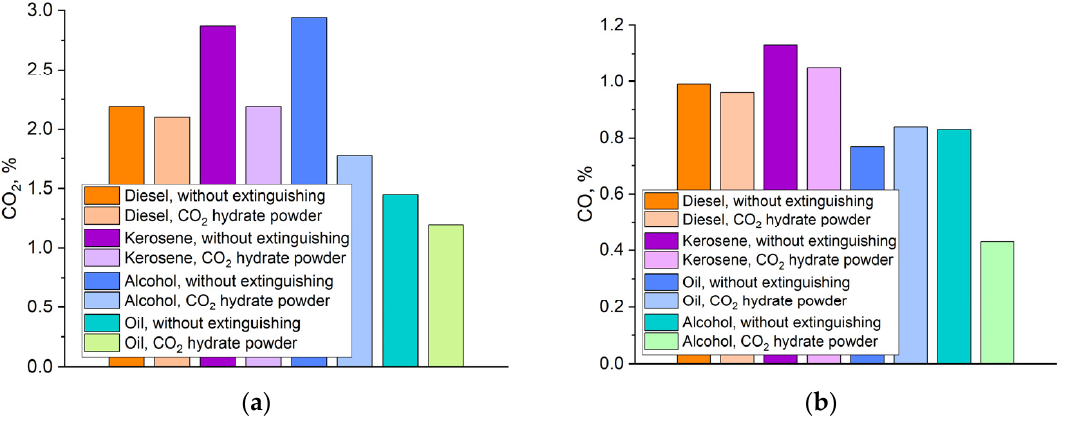
Figure 10. Concentrations of CO 2 ( a ) and CO ( b ) from the suppression of flammable liquids (diesel fuel, kerosene, oil, and alcohol) by CO 2 hydrate.